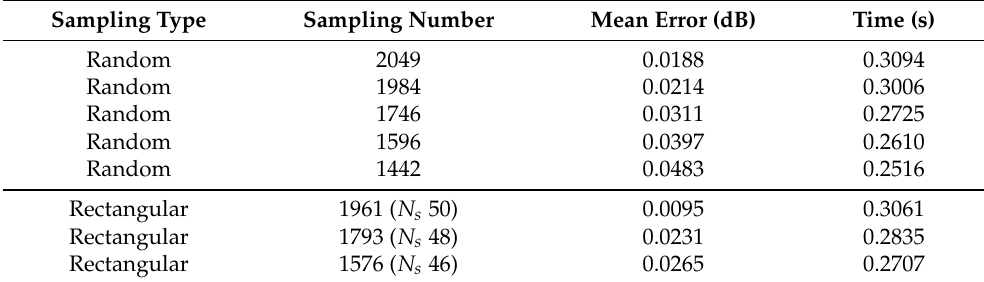
Table 3. Performance of Different Sampling Methods.